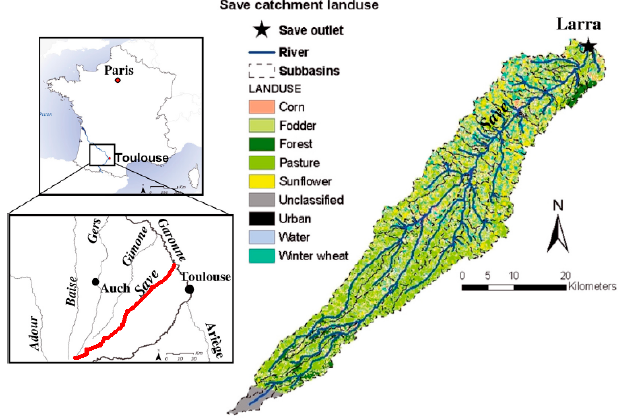
Figure 1. Localization of the Save catchment and the Larra sampling station (triangle) at the outlet. The land use map is extracted from [11].